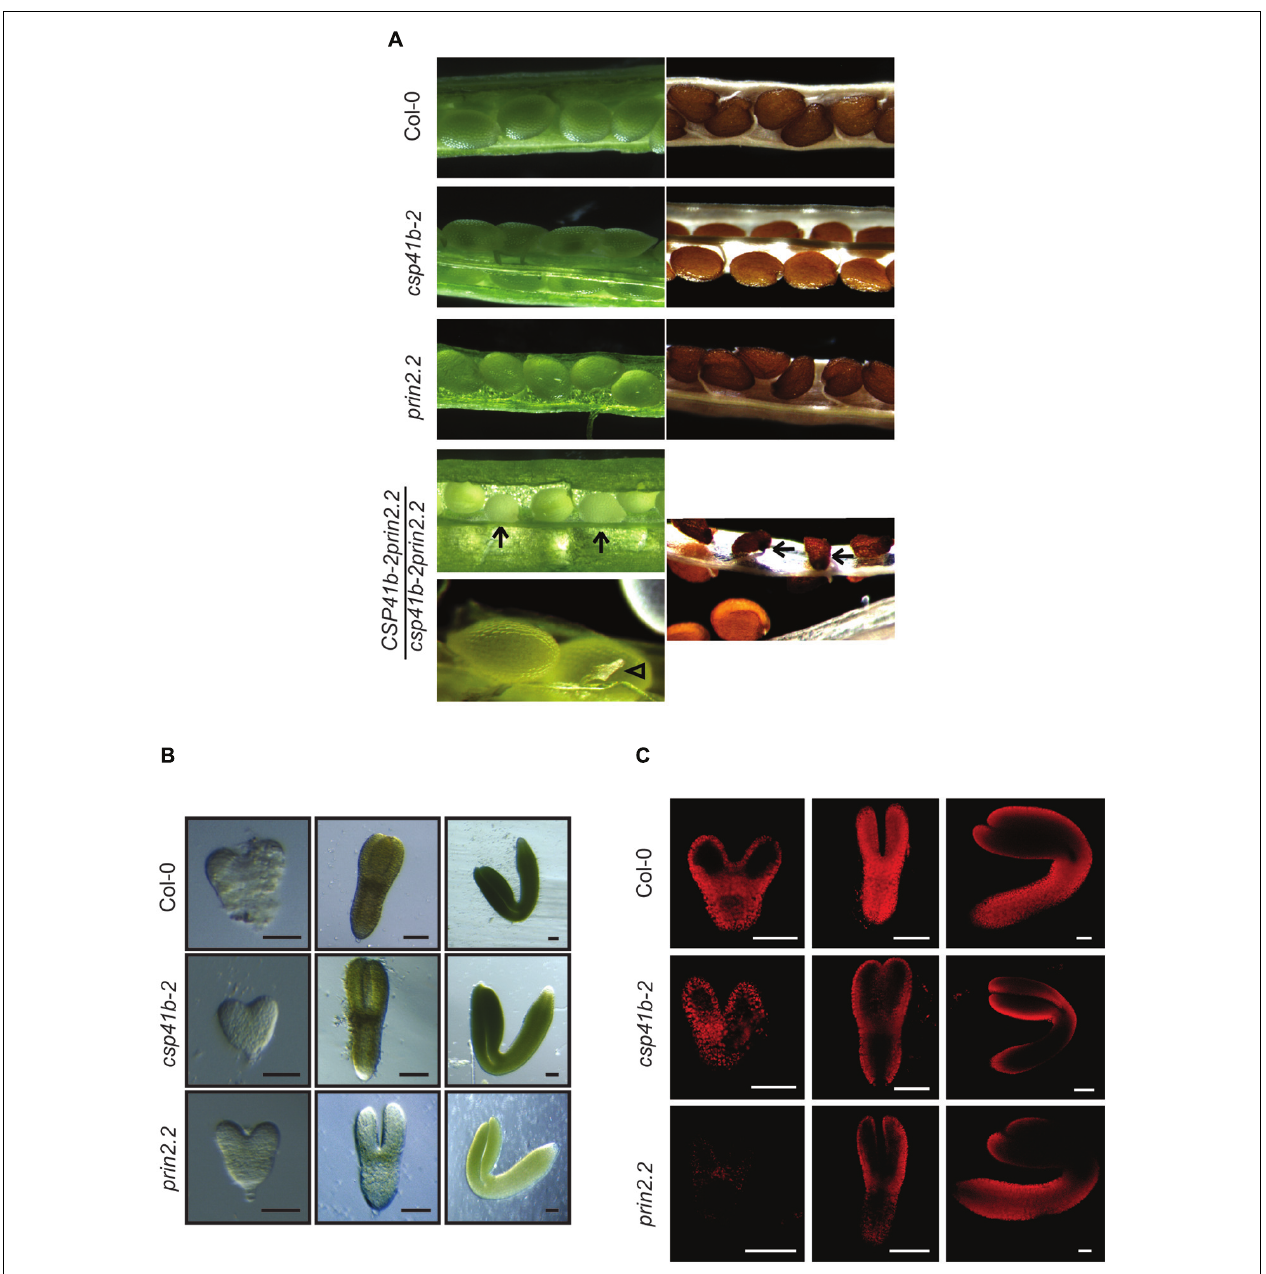
50 μ m. (C) Chlorophyll autofluorescence in Col-0, csp41b-2, and prin2.2 during specific stages of embryo development detected using confocal microscopy (Excitation wavelength 488 nm, Emission wavelength 687 nm). Representative images are shown for each genotype. Bars represent 50 μ